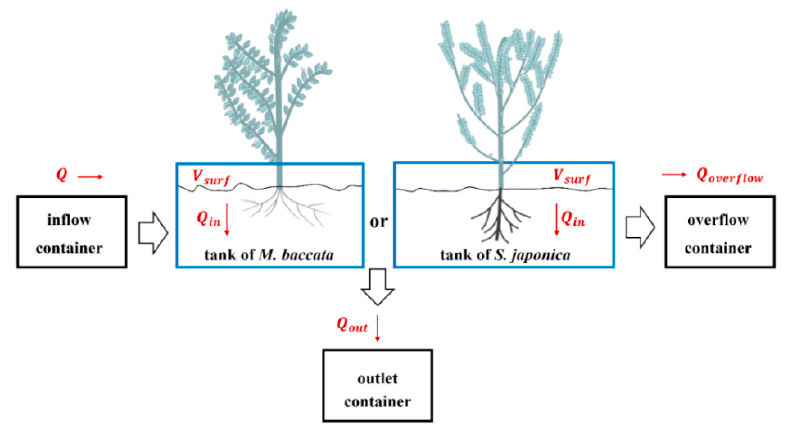
Figure 2. Schematic of the flow direction of water during the test.( Q is the rate of inflow to the test tank, dV surf / dt is the change over time in the water volume above the soil surface, Q overflow is the rate of overflow, Q in is the rate of flow into the soil, and Q out is the rate of outlet flow.)